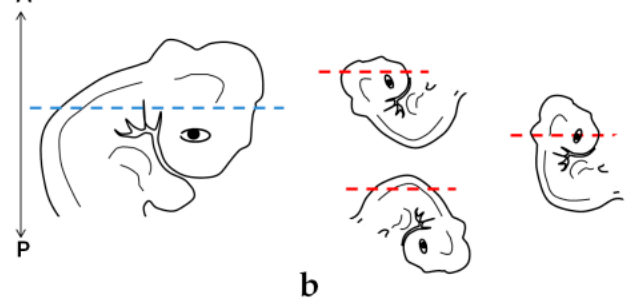
Figure 6. Embryo positioning in the block: ( a ) Desired orientation and plane of section (blue dashed line). ( b ) Orientations and planes of section (red dashed lines) obtained. A: Anterior portion of the block. P: Posterior portion.